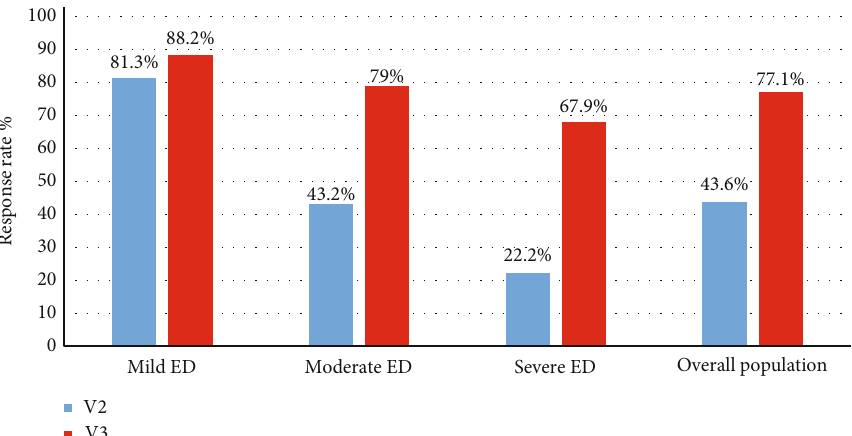
Figure 3: Response rate to the treatment in each group and in the overall population, based on IIEF-6 score, of Groups 1 (mild), 2 (moderate), and 3 (severe) at V2 and V3.